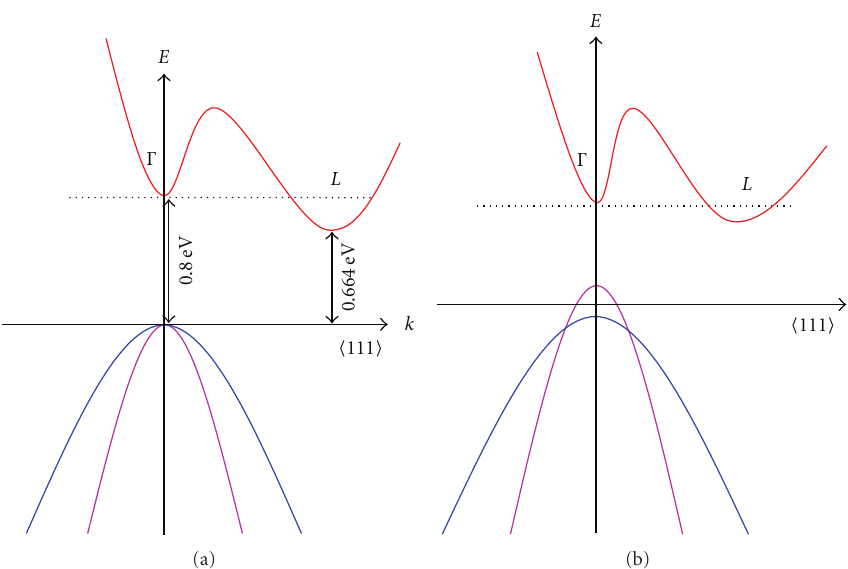
Figure 5: (a) Schematic band structure of bulk, showing a 136 meV di ff erence between the direct and indirect gap, (b) the di ff erence between the direct and indirect gap can be decrease by tensile strain.